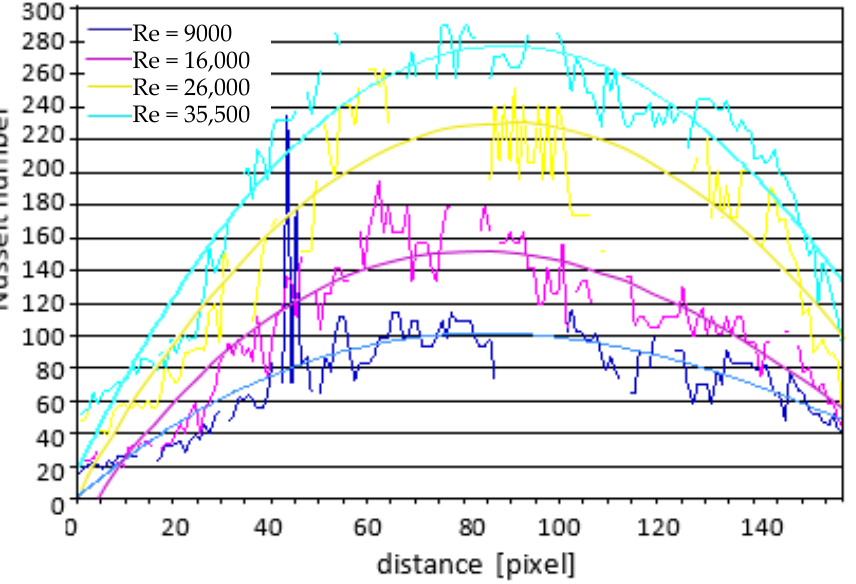
Figure 13. Local Nusselt numbers distribution for P/e = 11, configuration_2 and p4 mid-section.